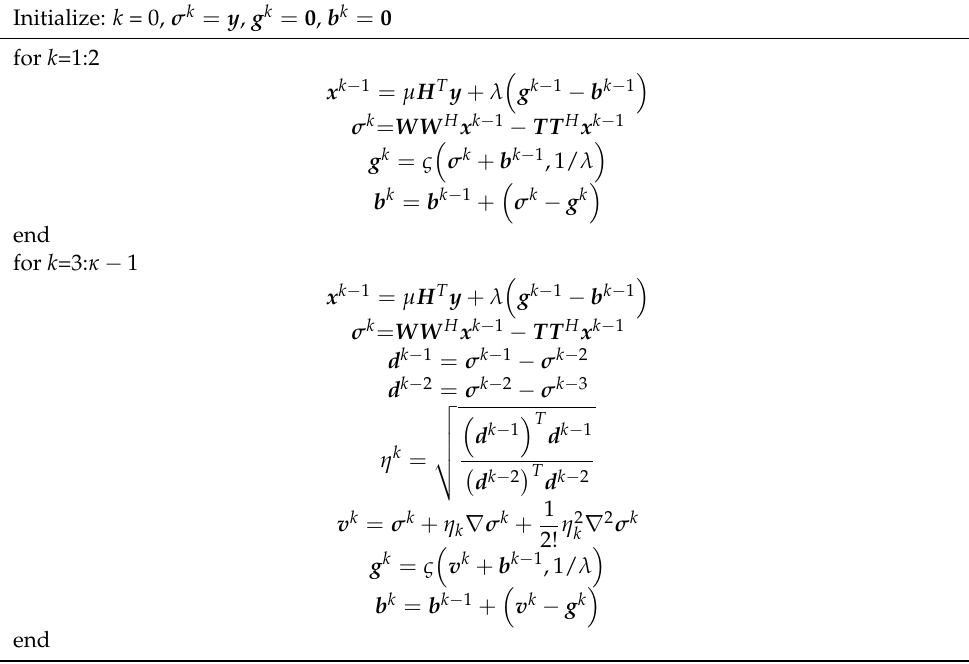
Table 1. Flow chart of the proposed a superfast split Bregman algorithm